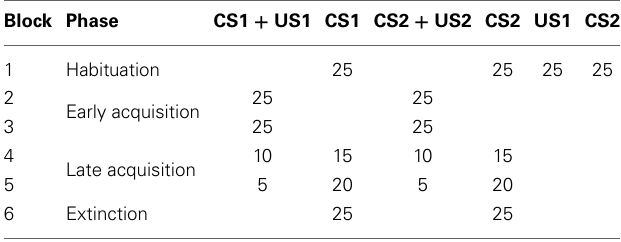
Table 1 | Summary of the